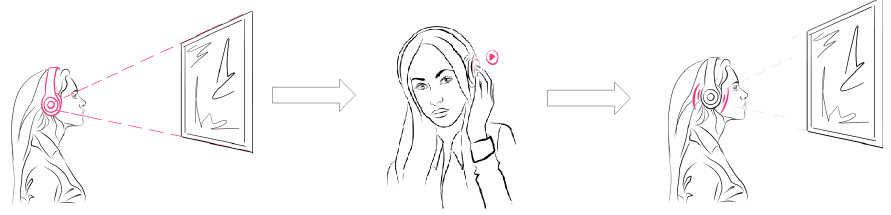
Figure 5. Hands-free museum guide